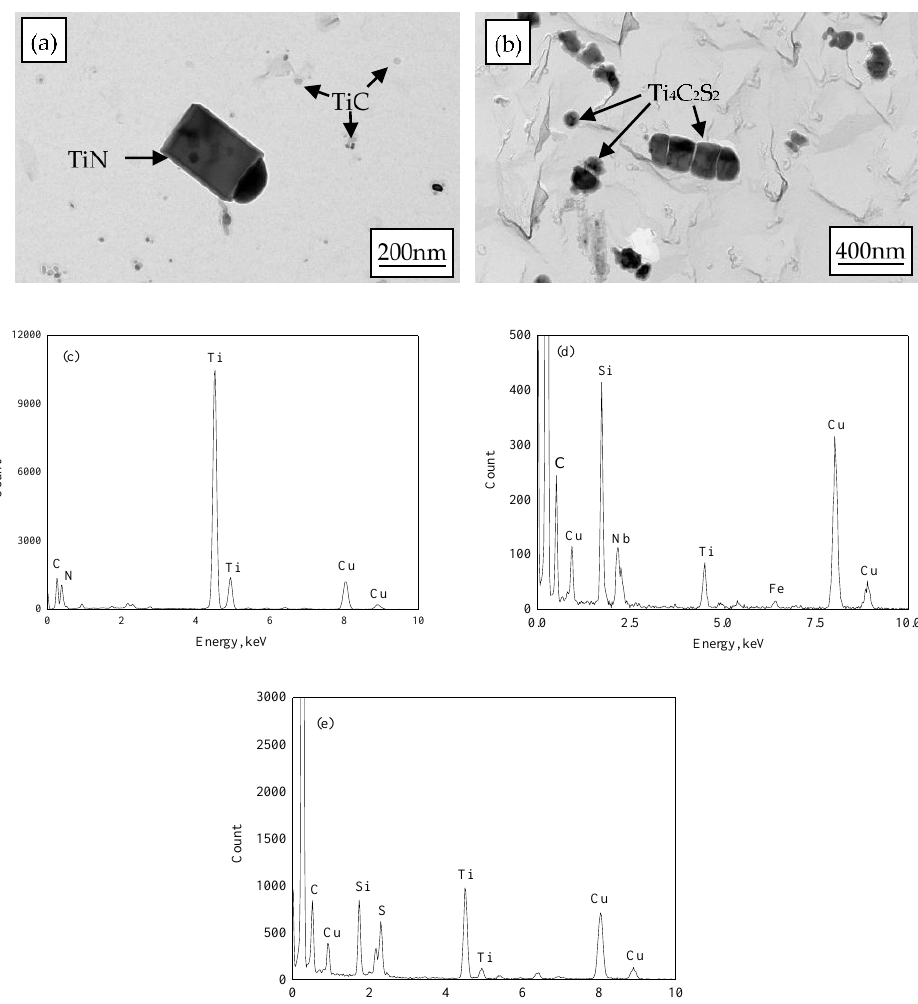
Figure 4. Transmission electron microscope (TEM) micrographs showing precipitates in experimental steel ( a ) TiN and TiC particles; ( b ) Ti 4 C 2 S 2 particles; ( c ) Energy dispersive spectrometer (EDS) spectrum of TiN; ( d ) EDS spectrum of TiC; ( e ) EDS spectrum of Ti 4 C 2 S 2 . Metals 2017 , 7 , 51